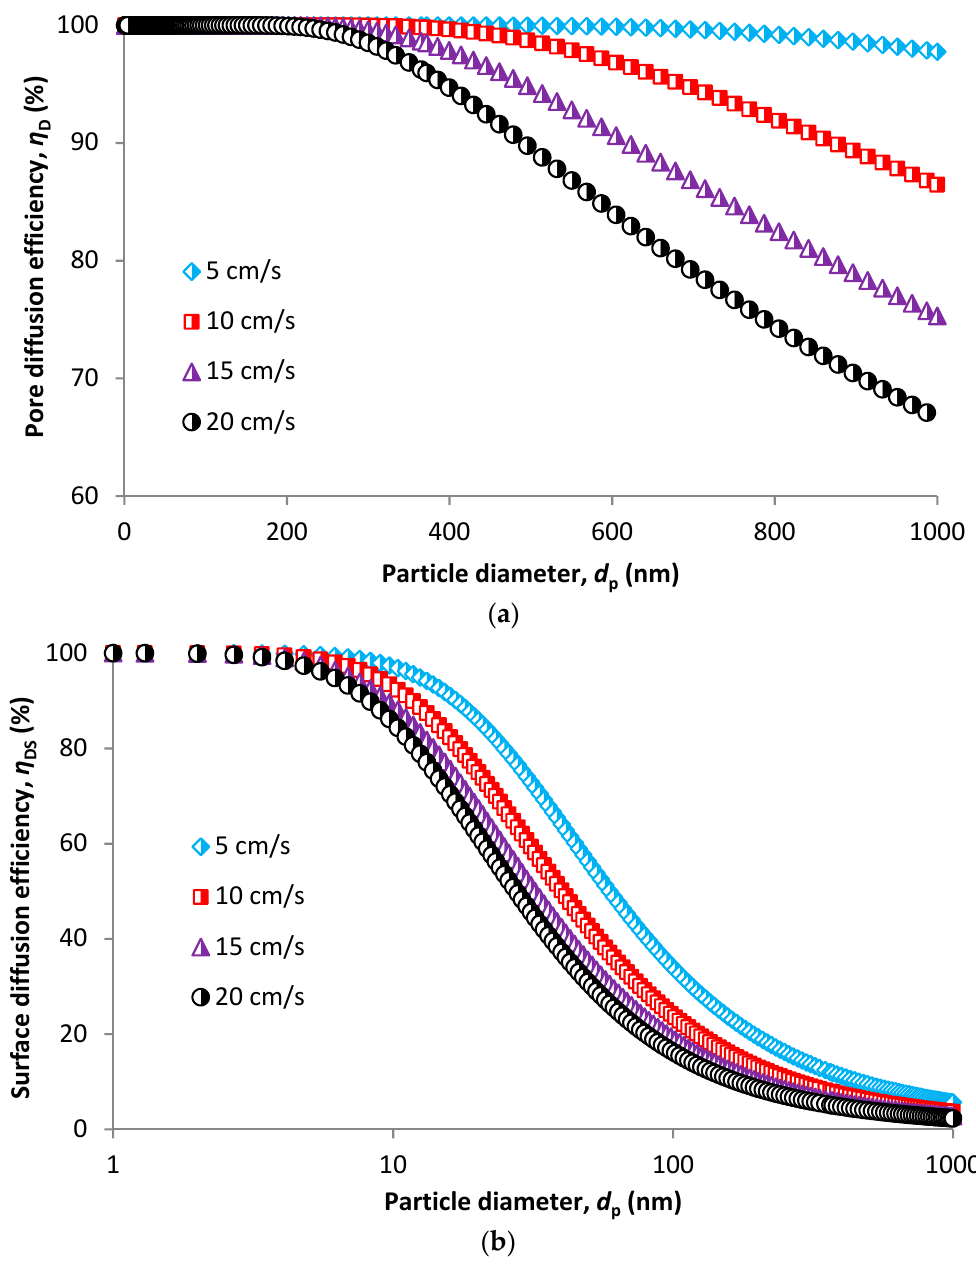
Figure 12. Collection efficiency due to diffusion in pores ( a ) and on the membrane surface ( b ).